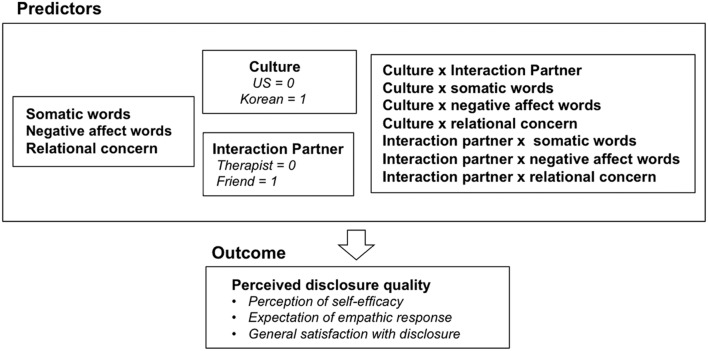
The summary of the variables included in the hierarchical multiple regression model in Study 1.